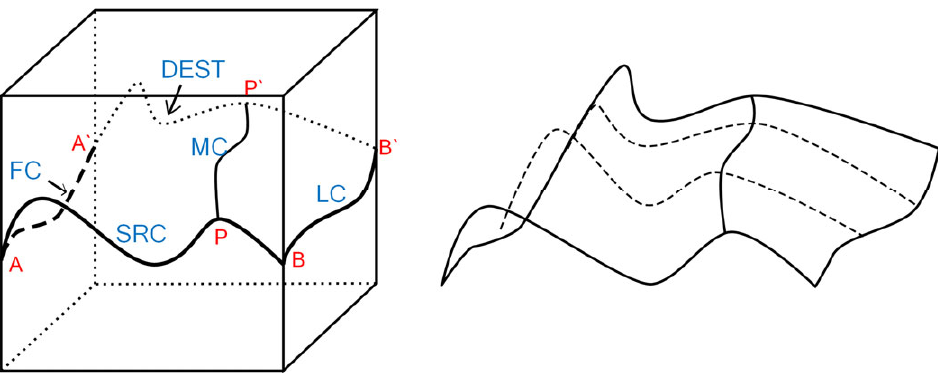
Figure 10. Principle of morphing interpolation.